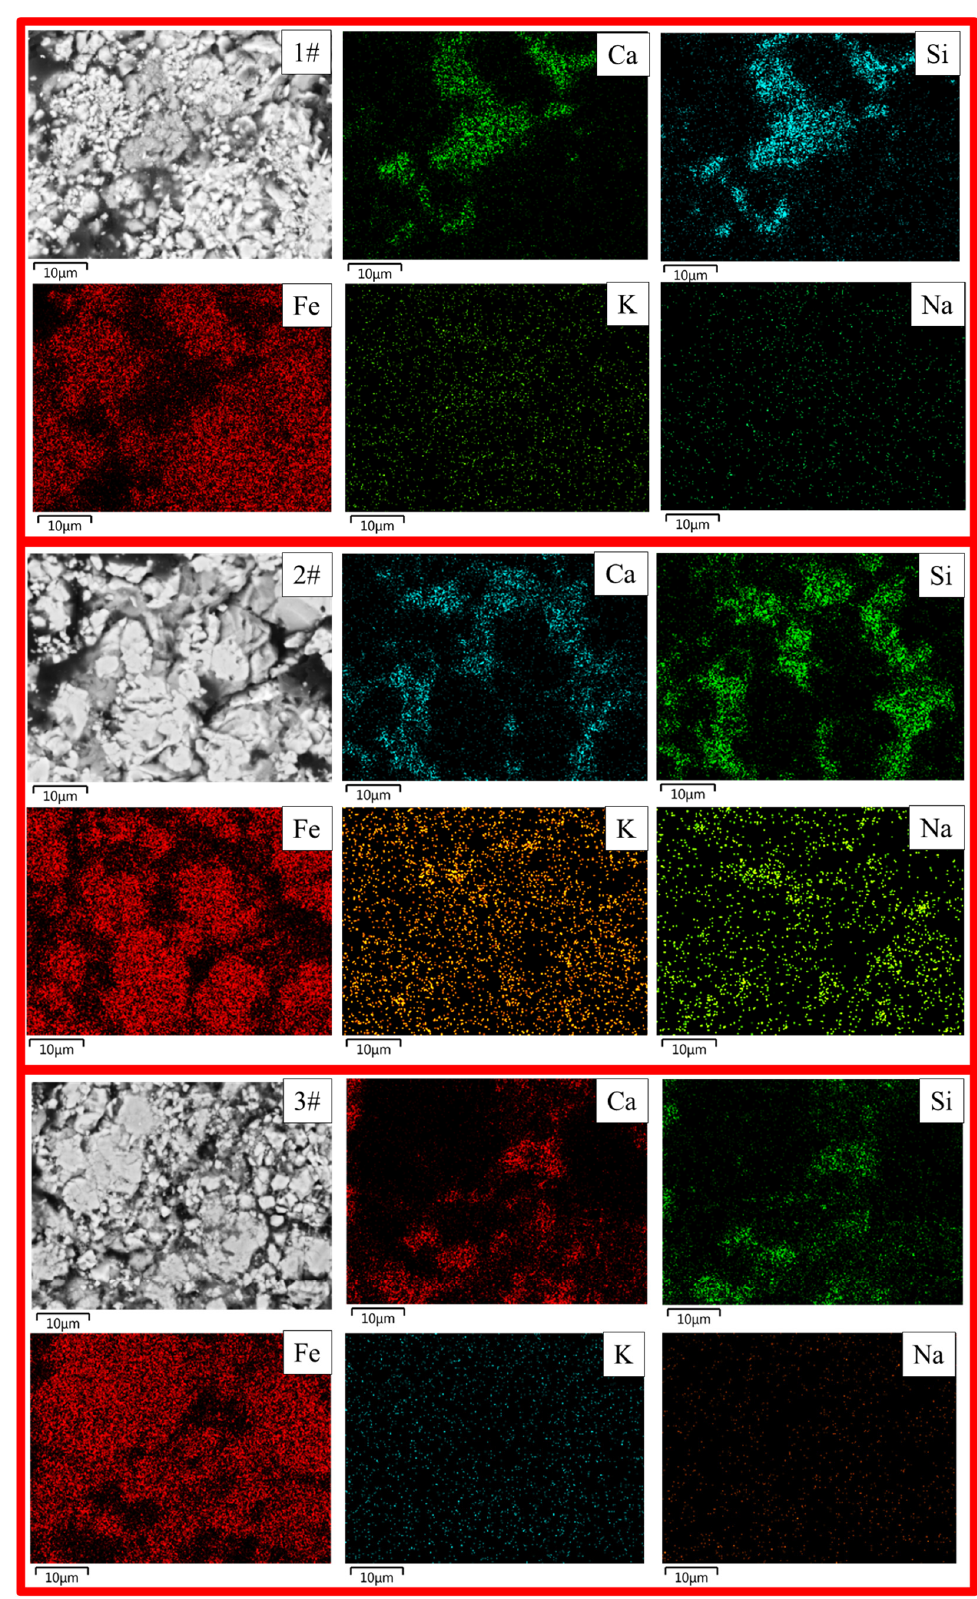
Figure 13. Energy-dispersive spectrum of the second reduction stage of iron oxides with different Figure 13. basicities.